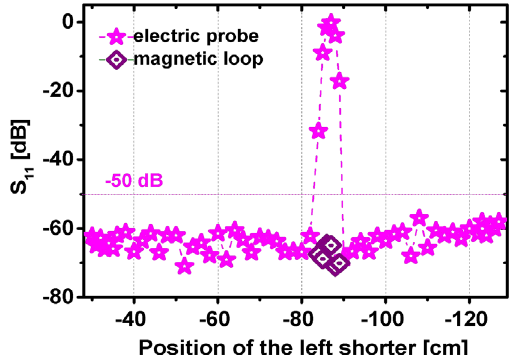
FIG. 17. The achievable S 11 of proof-of-principle structure for the test system within the entire moving